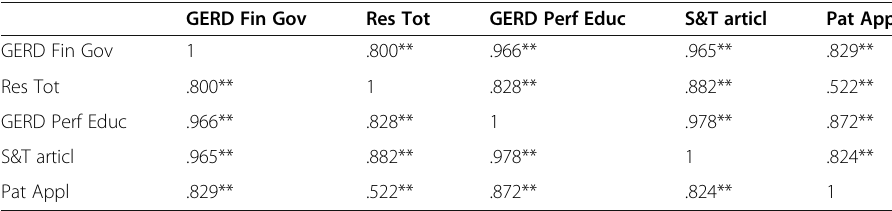
Table 2 Correlations matrix (KPP)